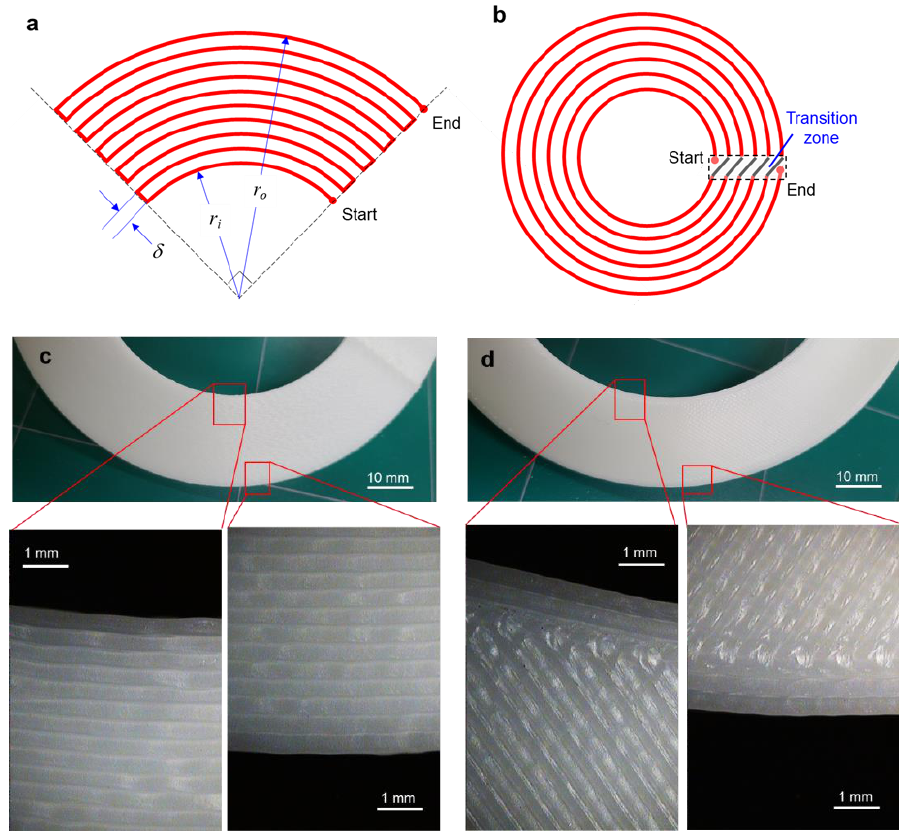
Figure 1. Configuration of printing paths for partial and full annuli: ( a ) circular printing path for a partial annulus; ( b ) circular printing path for a full annulus; ( c ) photographs of the printed disc with the circular printing path; ( d ) photographs of the printed disc with a typical printing path.